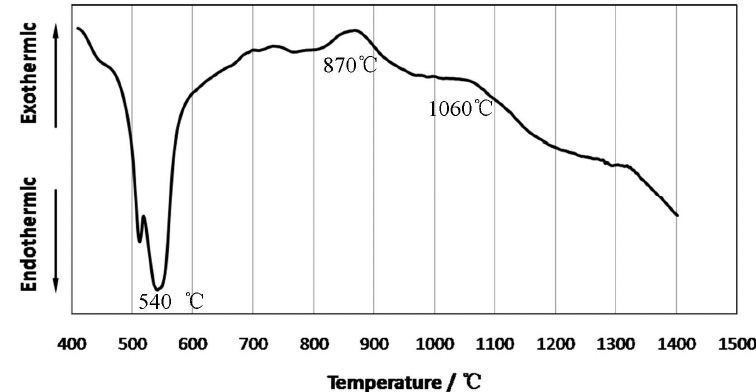
Figure 1. DTA profile of the TiH 2 -Si-C compact in an argon atmosphere with a heating rate of 10 K/min.